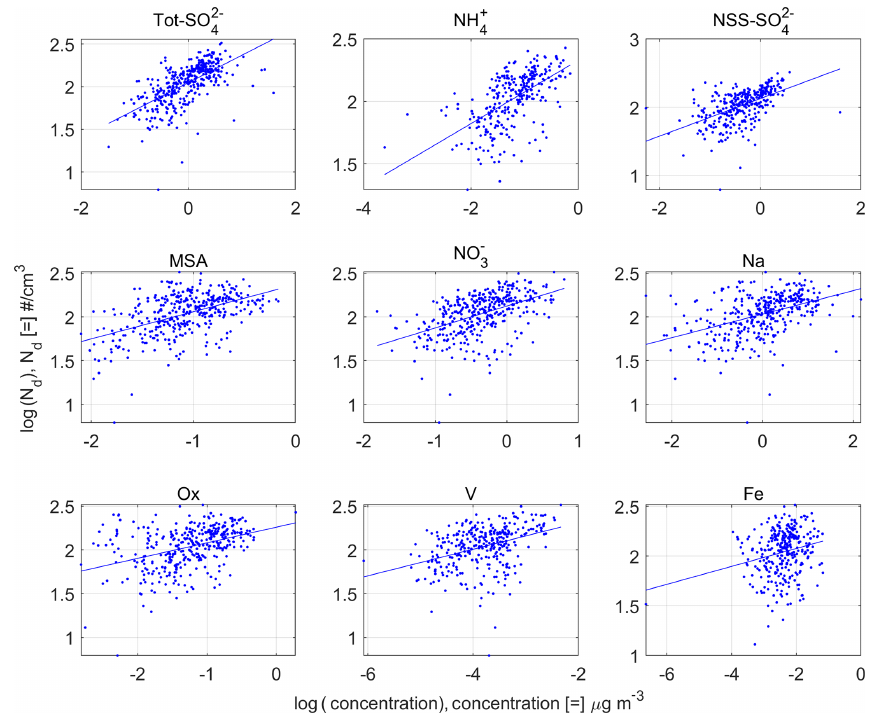
Figure 3. Scatter plot for the nine filtered species from Fig. 2. The lines are linear regression models of the form log (N d ) = a 0 + a 1 log (M i ) , where M i is the mass concentration of species i . Table 4. Comparison of coefficient values for studies that correlate N d to SO 2 −